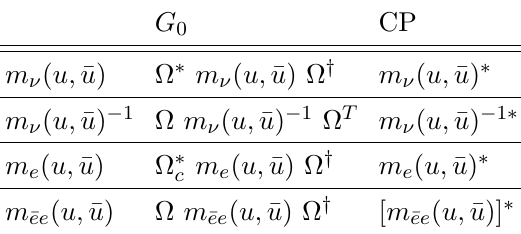
Table 4 . Transformation properties of the lepton mass matrices under the group G 0 and CP. We have defined: m ¯ ee ( u, ¯ u ) ≡ m e ( u, ¯ u ) † m e ( u, ¯ u )